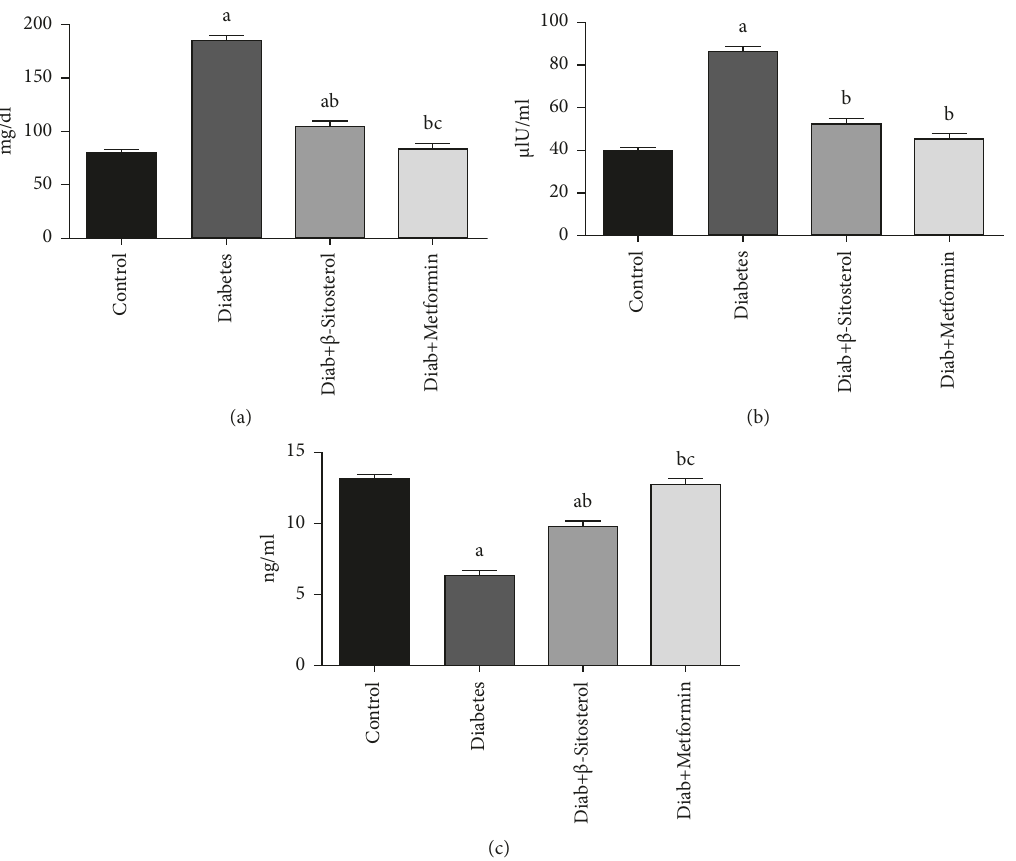
Figure 2: (a–c). The outcomes of β -sitosterol on fasting blood glucose, serum insulin, and testosterone in diabetic rats on a HFD and a sucrose-induced diabetic diet. Each bar indicates the mean ± SEM of six rats, with p < 0 . 05 indicating substantial differences between the groups as: a—control, b—HFD and sucrose-induced diabetic control, and c—HFD and sucrose-induced diabetic group treated with β -sitosterol. (a) FBG. (b) Serum insulin. (c) Serum